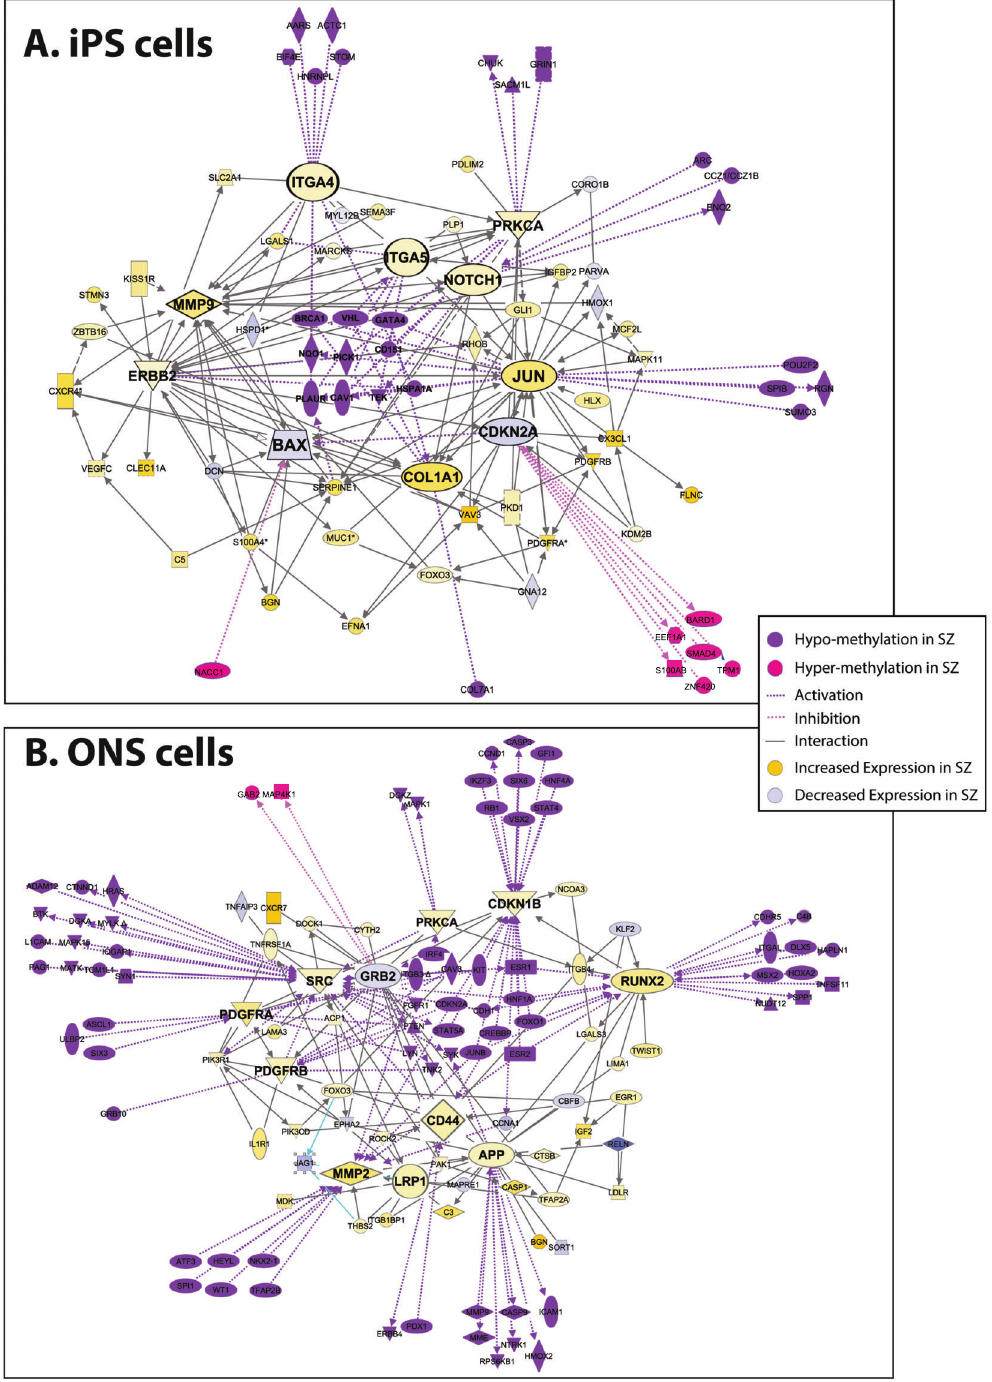
Fig. 3 Gene interactions among identi fi ed genes in cell movement. Interaction networks constructed from the genes that contributed statistically to the GO category cell movement: a iPS cell network; b ONS cell network. Differentially expressed genes in patient-derived and control-derived cells and contributing to cell movement ( yellow and blue symbols ) were subjected to network analysis based on fi rst-order connections between them ( lines ). Yellow symbols are genes with increased expression in patient-derived cells; blue symbols are those with decreased expression. The size of the symbols represents the magnitude of difference in gene expression between patient-derived and control-derived cells. Differentially methylated gene loci in patient-derived and control-derived cells were then mapped onto the gene expression network ( purple and pink symbols ). Purple symbols are hypomethylated loci; pink symbols are hypermethylated loci. The size of the symbols represents the magnitude of difference in DNA methylation between patient-derived and control-derived cells. First-order interactions of identi fi ed hypomethylated genes were associated with increased expression of identi fi ed genes, whereas hypermethylated genes were associated with decreased expression of identi fi ed